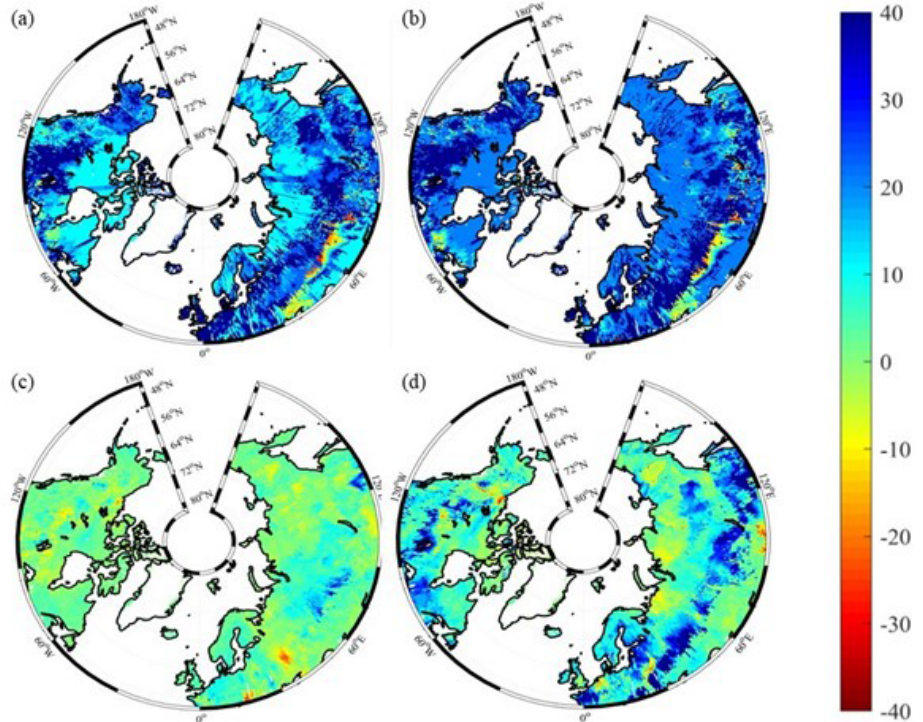
Figure 10. Spatial distribution of NEP simulated by TEM_Moss for the periods (a) 1900–1950 and (b) 1951–2000 and by TEM 5.0 for the periods (c) 1900–1950 and (d) 1951–2000. Positive values of NEP represent sinks of CO 2 into terrestrial ecosystems, while negative values represent sources of CO 2 to the